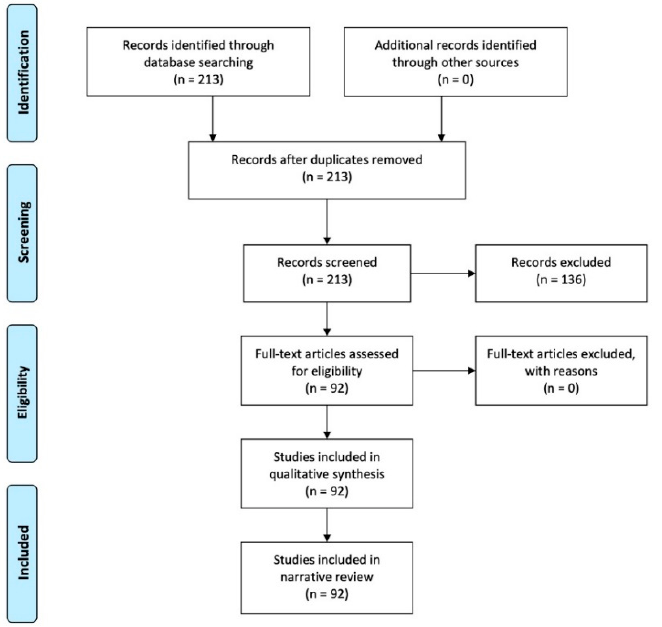
Figure 1. PRISMA flow diagram of studies selection.